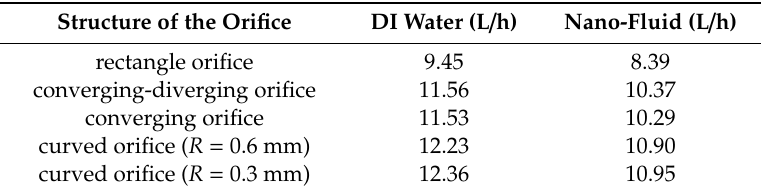
Table 2. Mass flow rate under different structures.